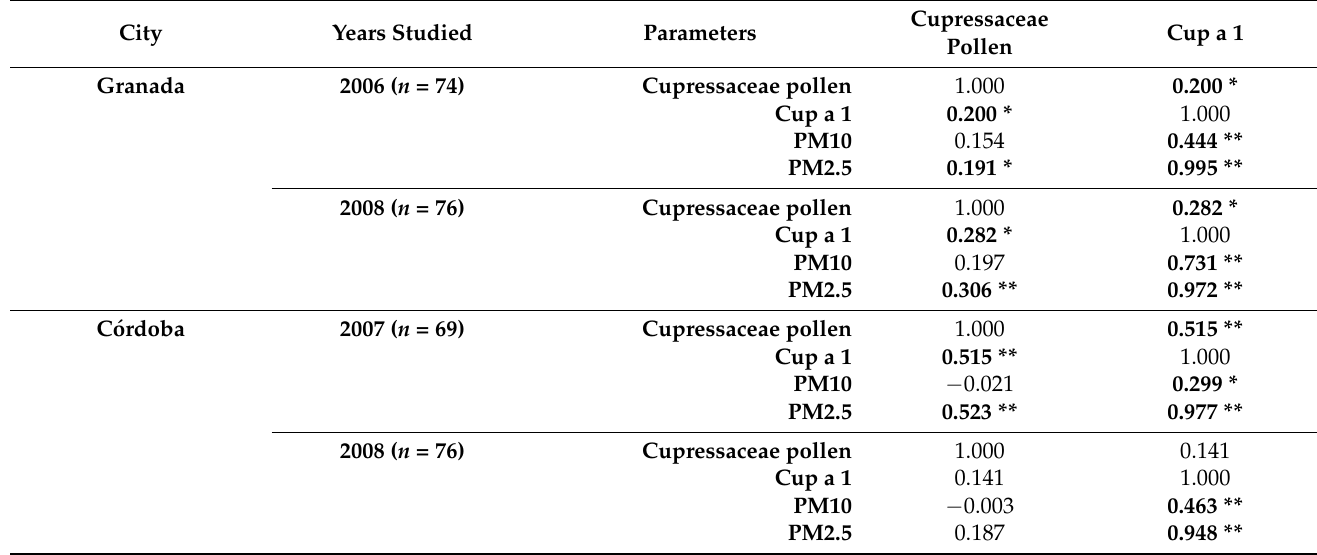
Table 2. Correlation coefficients for Cupressaceae pollen, Cup a 1 allergen, and allergens in PM10 and PM 2.5, ** p < 0.01; * p < 0.05. The shadow and bold format indicate the results more relevant. City C ó